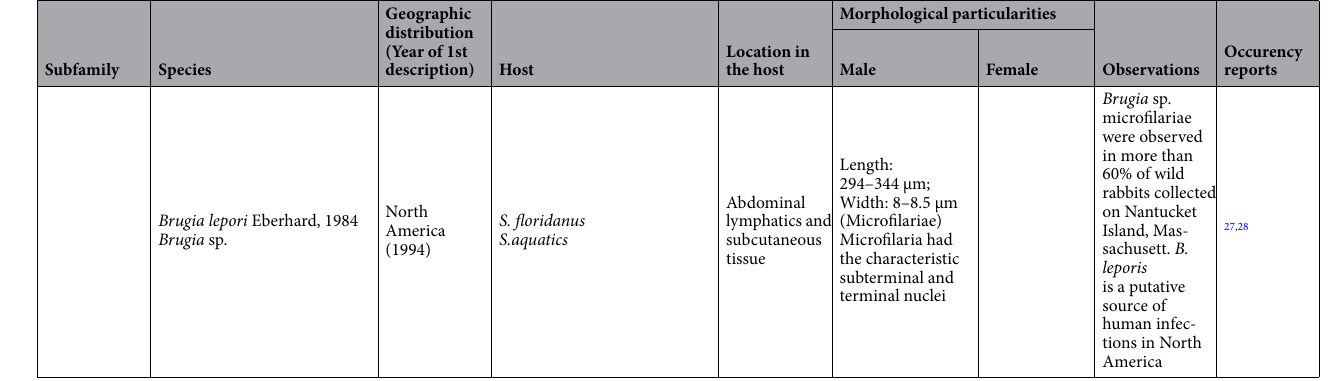
Table 1. Information on relevant filarial species found in rabbits and